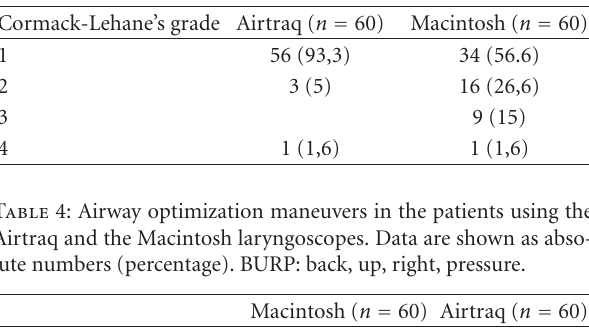
Table 3: Cormack-Lehane’s score in the patients using the Airtraq and the Macintosh laryngoscopes. Data are shown as absolute num- bers of patients (percentage).